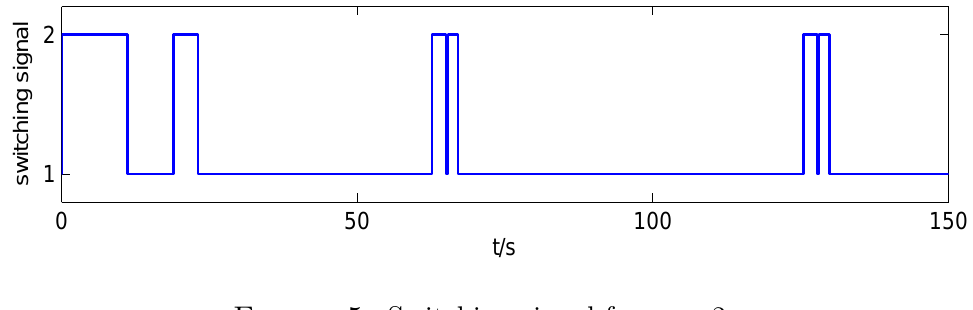
Figure 5. Switching signal for case 2